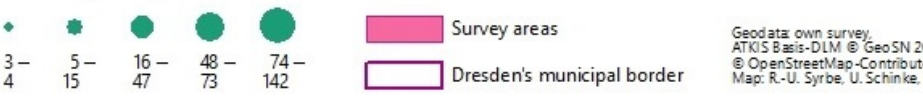
Figure 3. Survey areas in Dresden and the most popular green spaces (named at least three times in an open question) (source: authors’ elaboration).